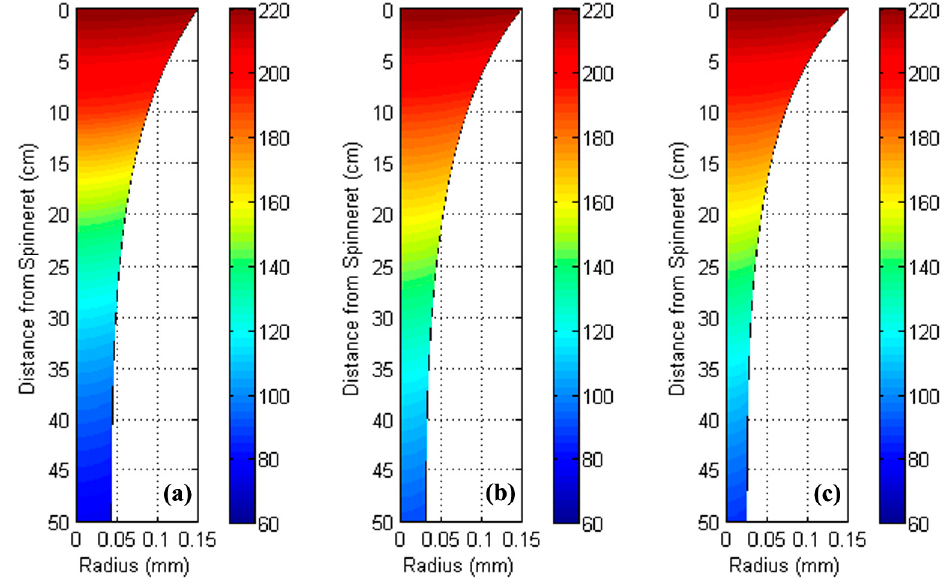
Figure 8. 2-D distributions of the temperature (°C) of PP/PS blend fibers at various take-up velocities: ( a ) 125, ( b ) 250, ( c ) 375 m/min [53]. Reproduced with permission from Chen, L.; He, H.; Zhang, Y.; Chen, Y.; Zhu, M., Fibers and Polymers; published by Springer Nature, 2015.